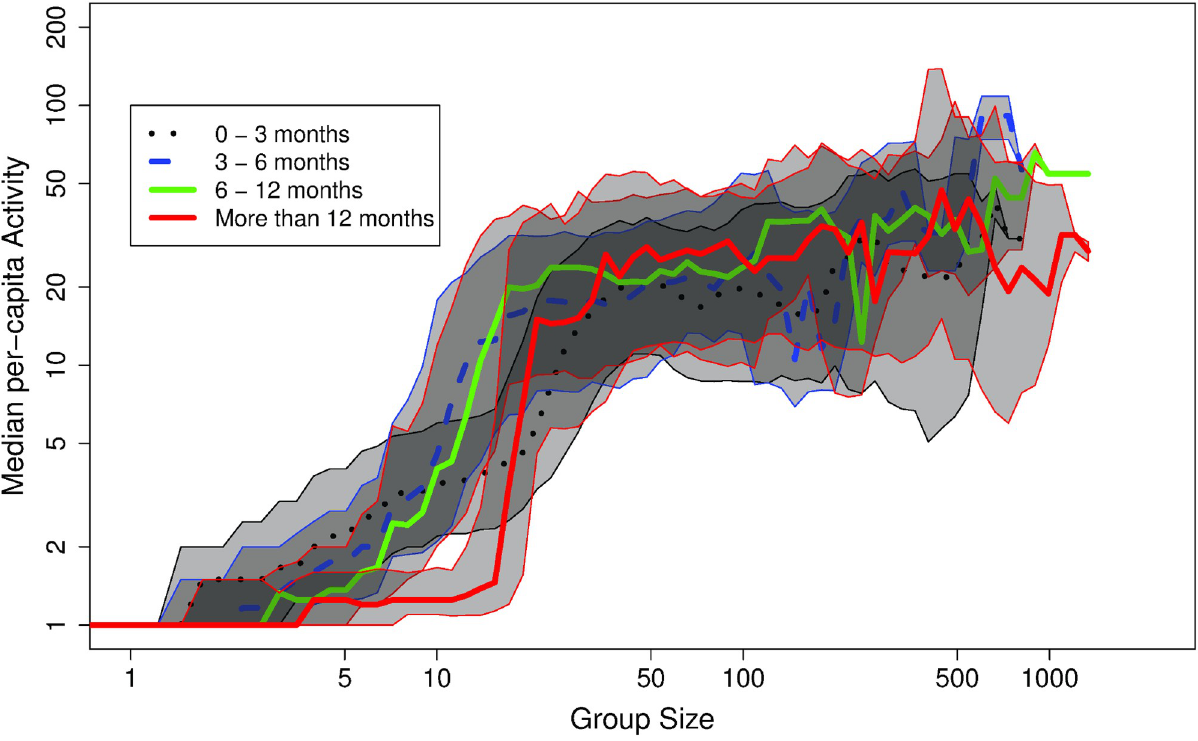
Fig 2. Mean activity across community sizes in the TAP data, for varying life stages in communities’ lifetimes. (a) younger than 3 months (black dotted curve), (b) between three and six months (blue dashed curve), (c) between six months and a year (green solid line) and (d) more than a year (red solid